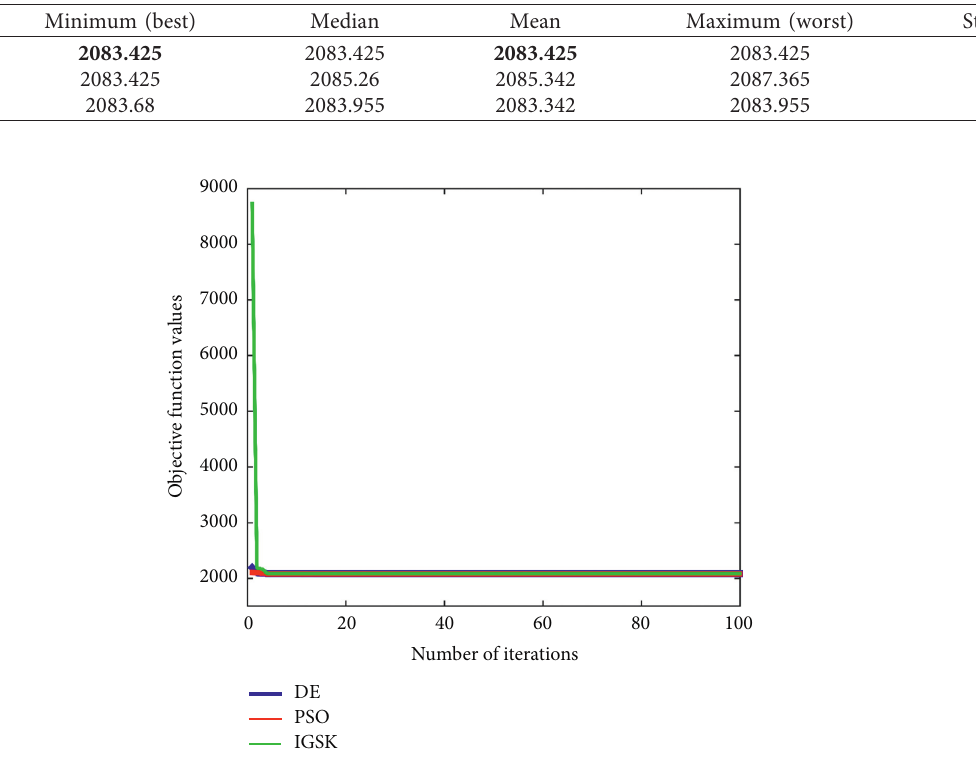
Figure 6: The convergence graph of the problem. Table 5: Demands and optimum solution for the case study.